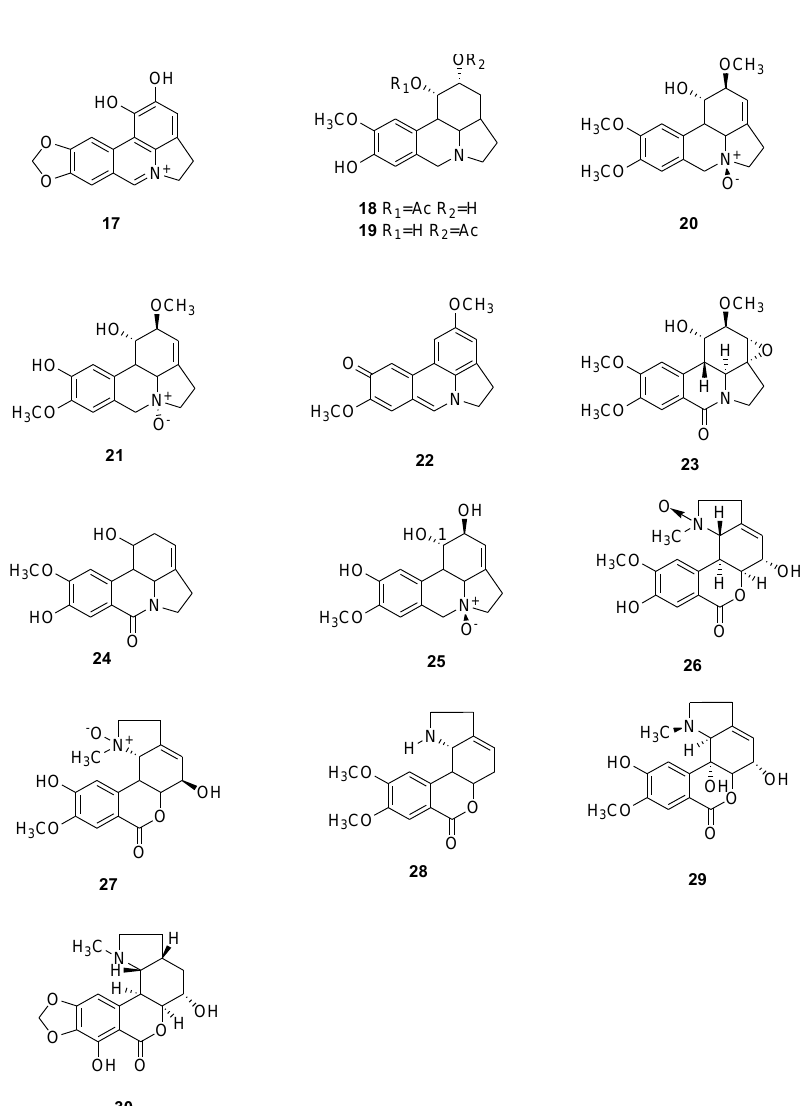
Figure 4. Chemical structure of new alkaloids of the lycorine- ( 17 – 25 ) and homolycorine-type ( 26 – 30 ). Numbers in bold refer to the compounds depicted in Table 2.